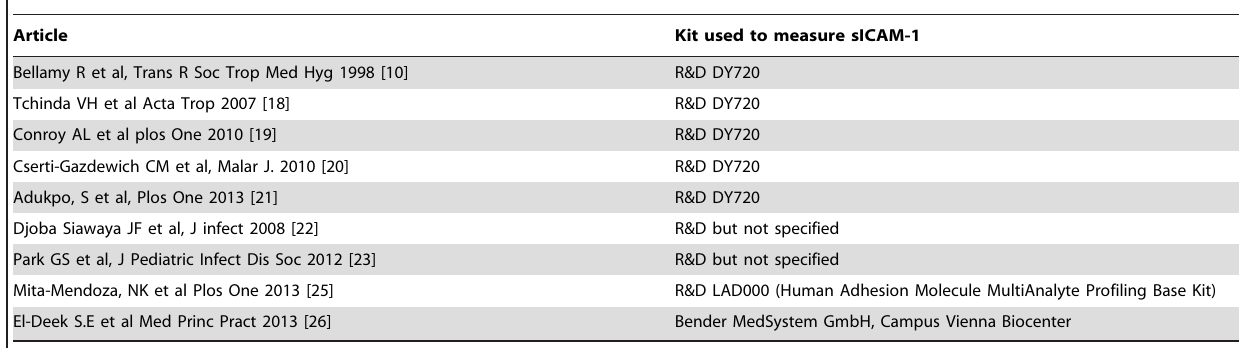
Table 1. Published work done in Africa that measure